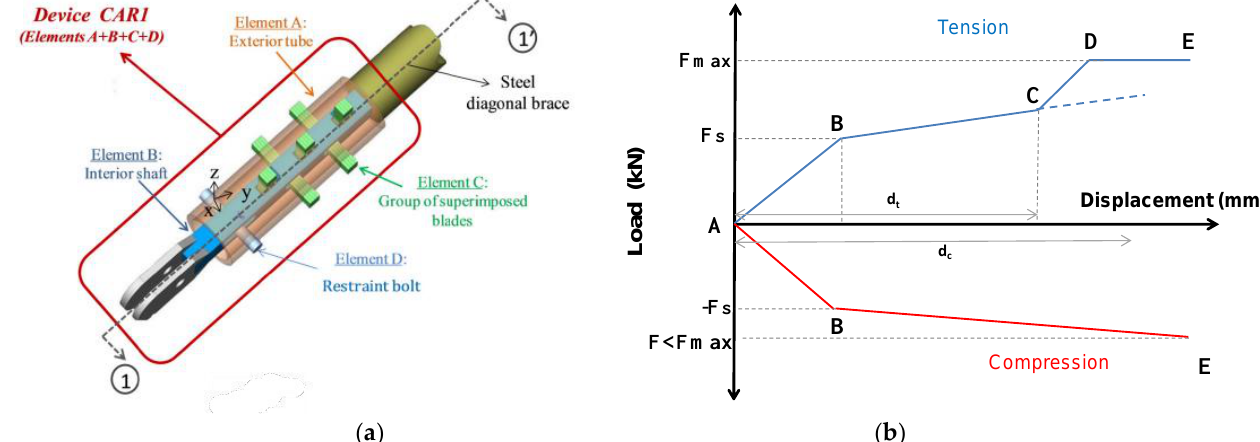
Figure 2. (a) Damper CAR1; (b) Non-linear behavior of the diagonal steel brace with CAR1 [18]. 138 Figure 2. ( a ) Damper CAR1; ( b ) Non-linear behavior of the diagonal steel brace with CAR1